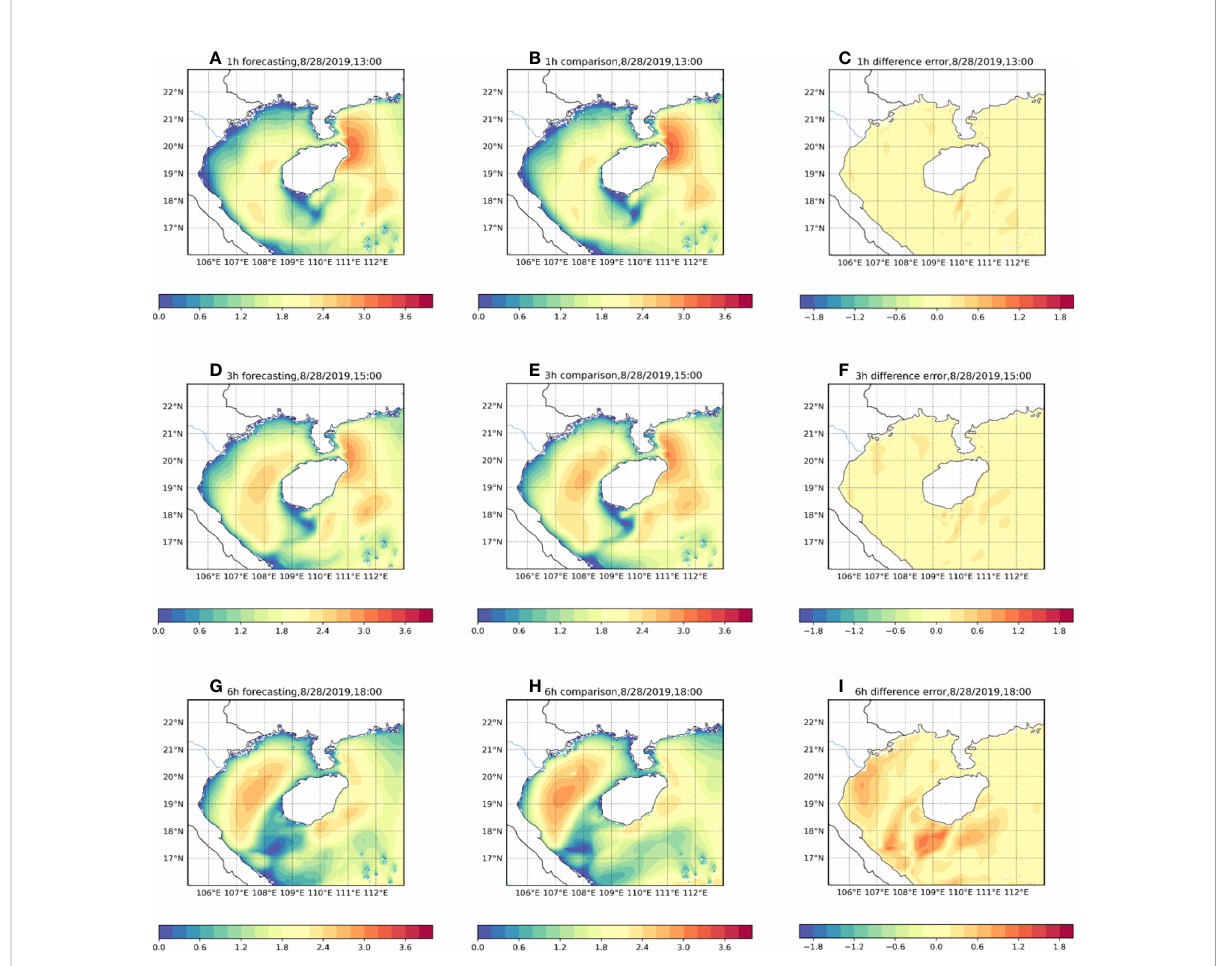
FIGURE 10 Comparison of forecast effect of the model under different forecast times. (A, D, G) are the predicted signi fi cant wave height effect diagrams for 1h, 3h, and 6h, respectively. (B, E, H) is the signi fi cant wave height diagram of the numerical model at the corresponding time. (C, F, I) is the difference error between forecasting and comparison.